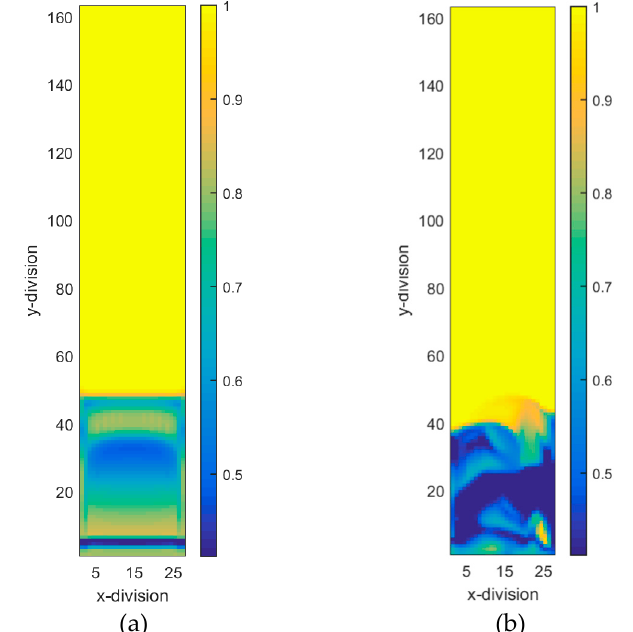
Figure 11. Gas volume fraction distribution initially in the bed at time-step = 100 ( a ) and later when it is fully fluidized at time-step = 4000 ( b ).